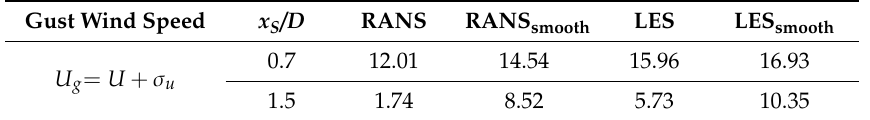
Table 1. Gust wind speed in m / s, calculated for the di ff erent methods at x S / D = 0.7 and x S / D =